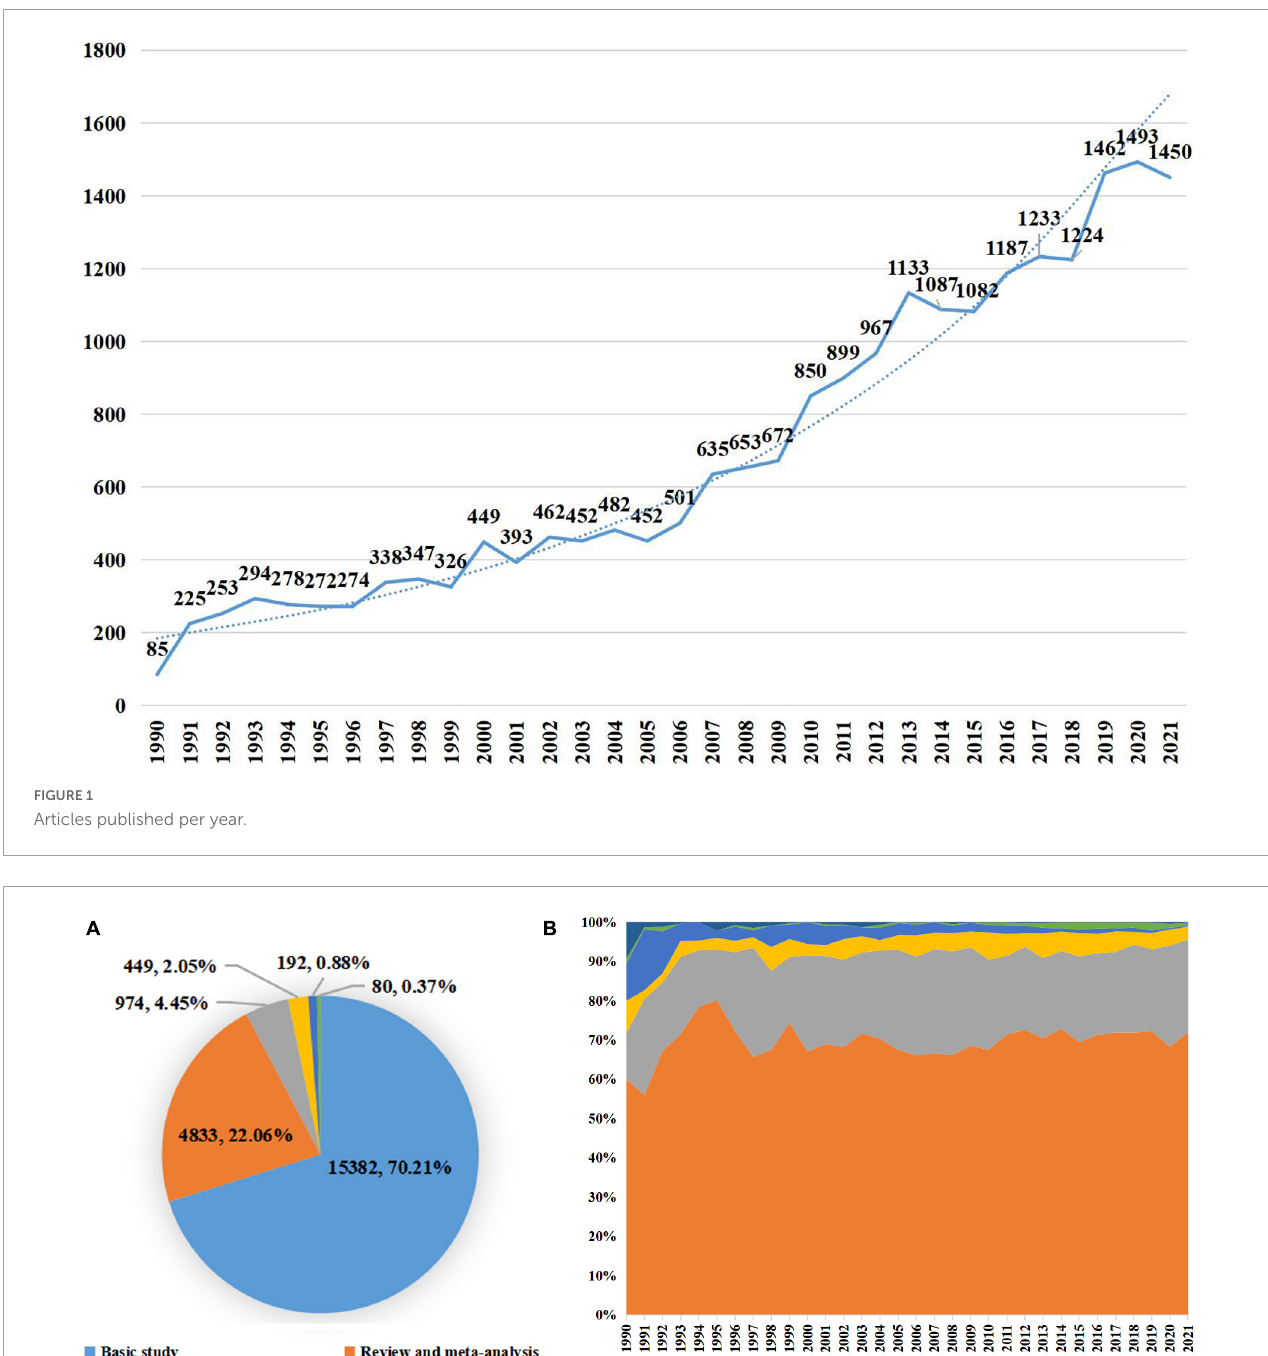
FIGURE2 Distribution of publication types. (A) The total number and proportion of different publication types on cellular senescence in the past 30 years; (B) the distribution of different publication types per year.